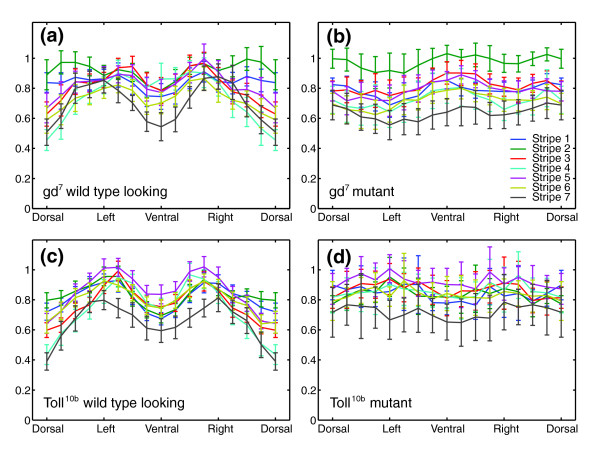
gd and Tl regulate the levels of ftz stripe expression in the direction of the d/v axis. Plotted are averaged expression intensities of gene stripes for ftz in wild-type-like embryos derived from (a) gd7 heterozygous mothers, (b) dorsalized mutant embryos from gd7 homozygous mothers, (c) wild-type-like embryos from Tl10B heterozygous mothers, and (d) ventralized mutant embryos derived from Tl10B homozygous mothers. Expression intensity (y-axis) is plotted against the location along the stripe in the direction of the d/v axis as described in [12]. Each of the seven ftz stripes is shown in a different color and the error bars give the 95% confidence intervals for the means. The differences in expression seen in wild-type embryos in the direction of the d/v axis are not seen in the mutant embryos.